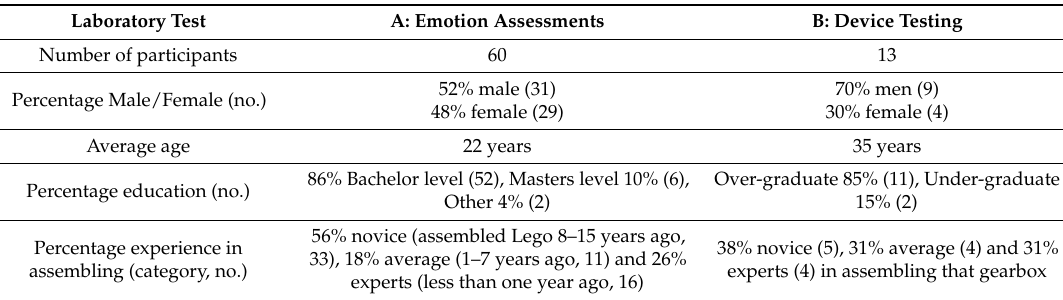
Table 3. Participant data for Laboratory Tests A and B.